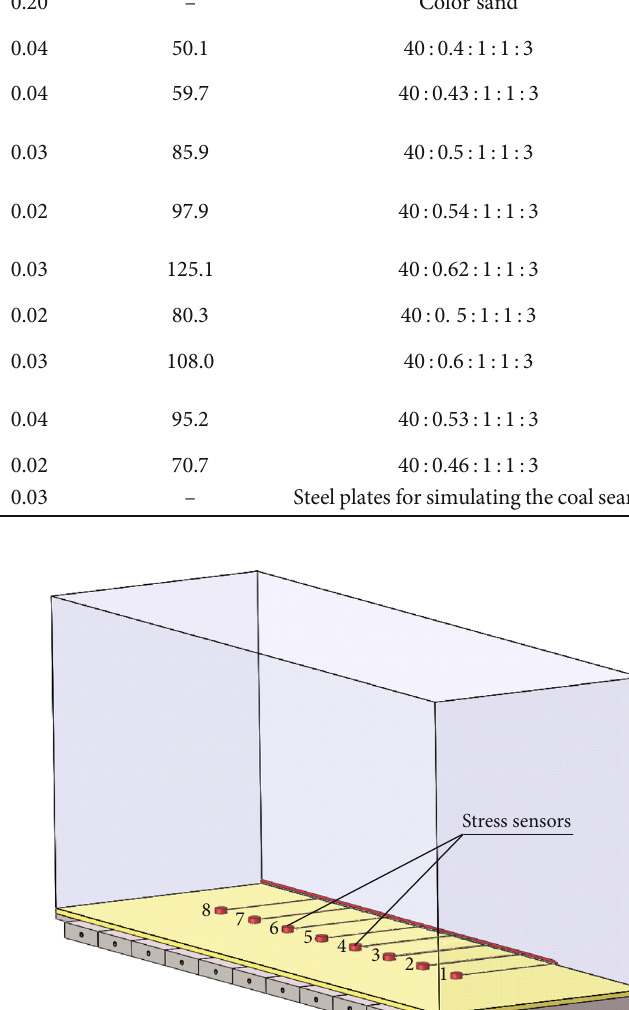
Figure 7: E ff ect of para ffi n content to the parameters of similar material.